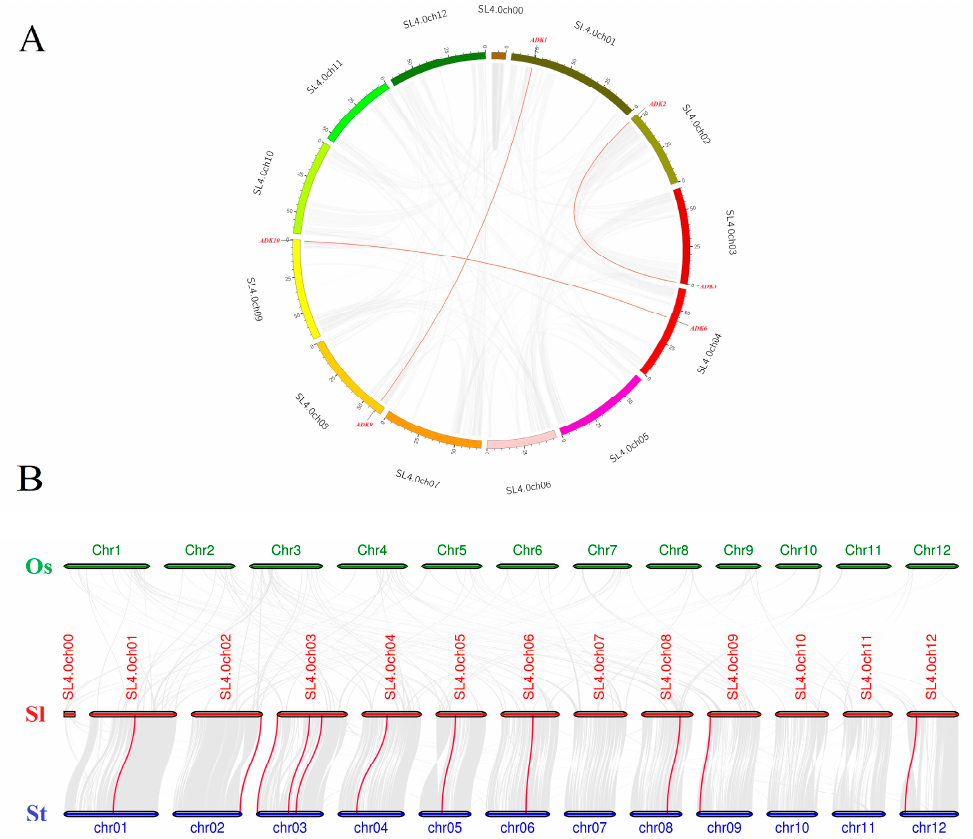
Figure 4. Collinearity analysis of ADK gene family . ( A ) Synteny analysis of the ADK family in tomato. The gray lines represent the collinearity result of the tomato genome, and red lines linking SlADK genes represent the duplication events occurring in the tomato ADK gene family. Chromosomes are drawn in different colors, and the approximate location of SlADK genes is shown by short black lines on the circle. ( B ) Synteny analysis of ADK genes between tomato and other two representative plant species. The gray lines in the background represent the collinear blocks within tomato and other plant genomes (potato, rice), while the red lines highlight the syntenic ADK gene pairs. Here the abbreviations “Os”, “Sl”, and “St” indicate Oryza sativa , Solanum lycopersicum , and Solanum tuberosum , respectively.